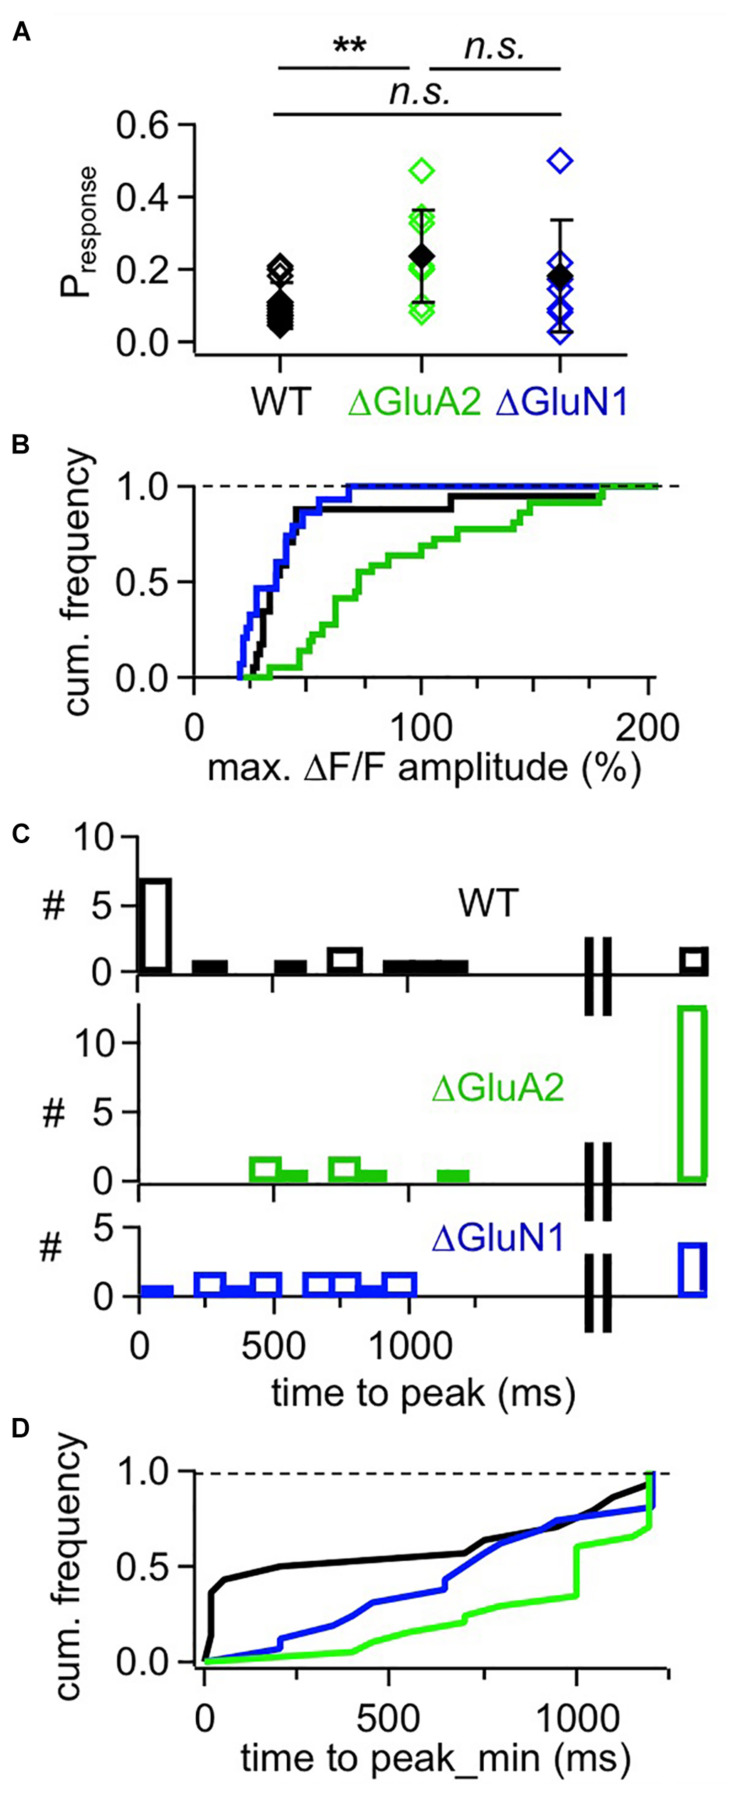
Cumulative analyses of responses in adult mouse WT, ΔGluA2 and ΔGluN1 GCs. (A) Estimated likelihood of observing a (ΔF/F)syn response upon glomerular stimulation (“response probability,” calculated as number of responses divided by number of stimulations). Pairwise comparison (Mann-Whitney test) and Bonferroni: Pr WT vs. ΔGluA2: P = 0.0018, ΔGluA2 vs. ΔGluN1: P = 0.42, WT vs. ΔGluN1: P = 0.51. (B) Frequency distribution of (ΔF/F)syn response amplitudes for the three GC groups. WT is different from ΔGluA2, but not from ΔGluN1 (P < 0.001 and P = 0.16, Kolmogorov-Smirnov). (C) Distributions of (ΔF/F)syn response time to peak for the three GC groups. The rightmost bar shows the responses where the peak might not yet have been reached within the scanning time window (up to 1,200 ms post stimulation). (D) Frequency distribution of (ΔF/F)syn response time to peak for the three GC groups, with peaks possibly beyond scan window set to 1,200 ms (minimal time to peak). WT is different from ΔGluA2, but not from ΔGluN1 (P = 0.02 and P = 0.09, Kolmogorov-Smirnov test).